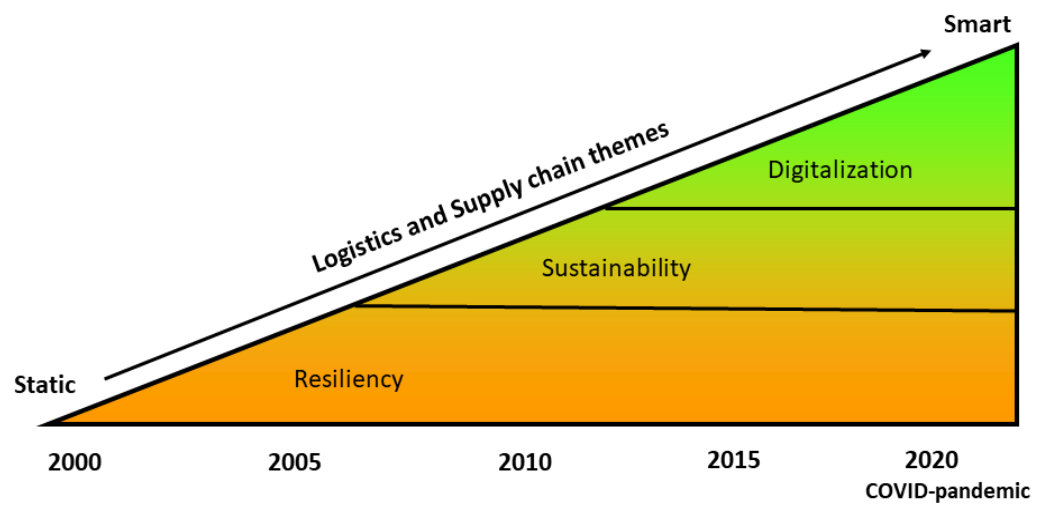
Figure 1. The evolution of the three key concepts based on Ivanov [9]. Resiliency refers to the ability of an entity to adapt to both positive and negative shocks and disruptions caused by both internal and external environments [24]. The first studies on resiliency in the context of supply chains and logistics, which are still of relevance today, date back to the early 2000s [9,25,26]. The resiliency of the chain relates to visibility, managing risks, and reducing the complexity of networks [27].